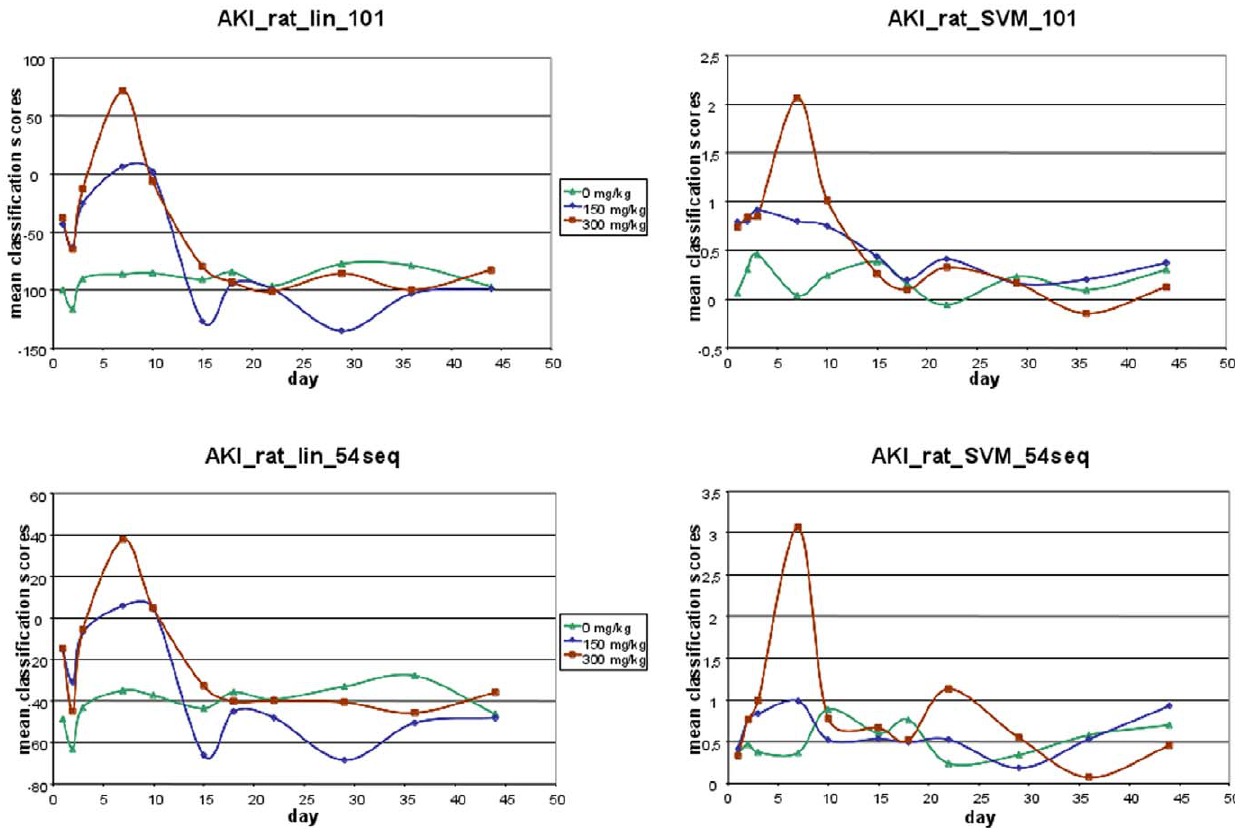
Figure 3. Time course of nephrotoxicity classification by the urinary models composed of gentamicin-sensitive polypeptide markers. Mean classification factors obtained with the linear (left row) and SVM (right row) model variants of the marker panels AKI_rat_lin_101 (upper panel) and AKI_rat_lin_54seq (lower panel) for urine samples from untreated animals (green curve) and animals treated with 150 (blue curve) and 300 mg/kg (red curve) gentamicin once daily for three consecutive days over time.